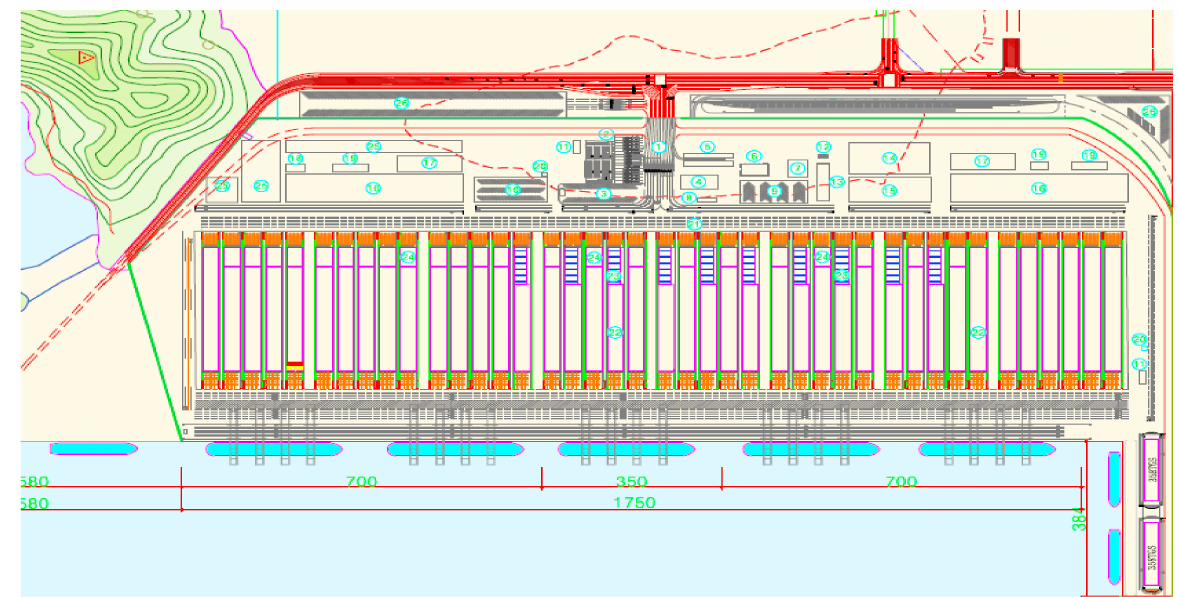
Figure 2. Automated container terminal (ACT) layout with 5 berths (Source: